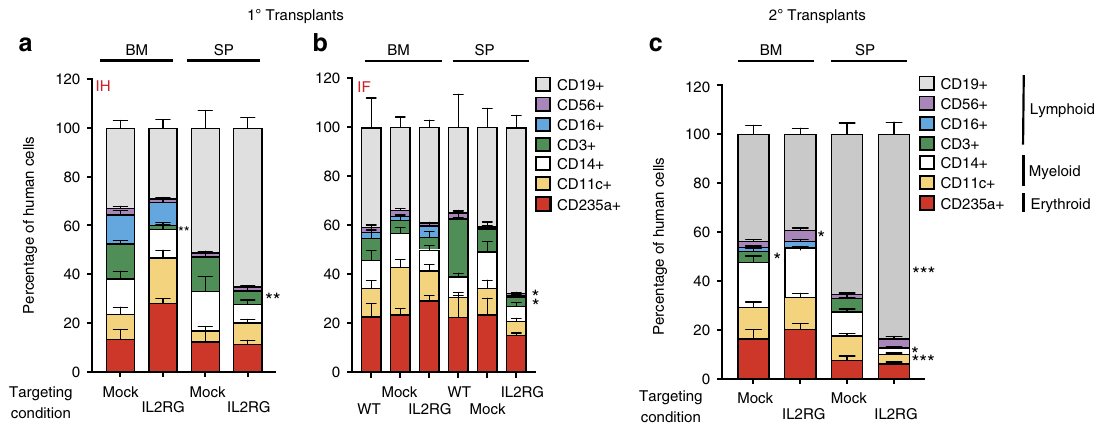
Fig. 3 Normal multi-lineage development from IL2RG cDNA targeted in the LT-HSC population. a Percent cellular composition of the lymphoid, myeloid and erythroid lineage derived from IH 1° human engraftment, shown in indicated organs and targeting conditions. CD3 + BM: ** p = 0.0017, CD3 + SP: ** p = 0.007 (Welch ’ s t -test). b Same as ( a ) but IF transplant analysis. CD3 + SP: * p = 0.023, CD56 + BM: * p = 0.015 (Kruskal – Wallis test). c Percent cellular composition of the lymphoid, myeloid and erythroid lineage derived from secondary transplants. Data shown are combined IH and IF primary